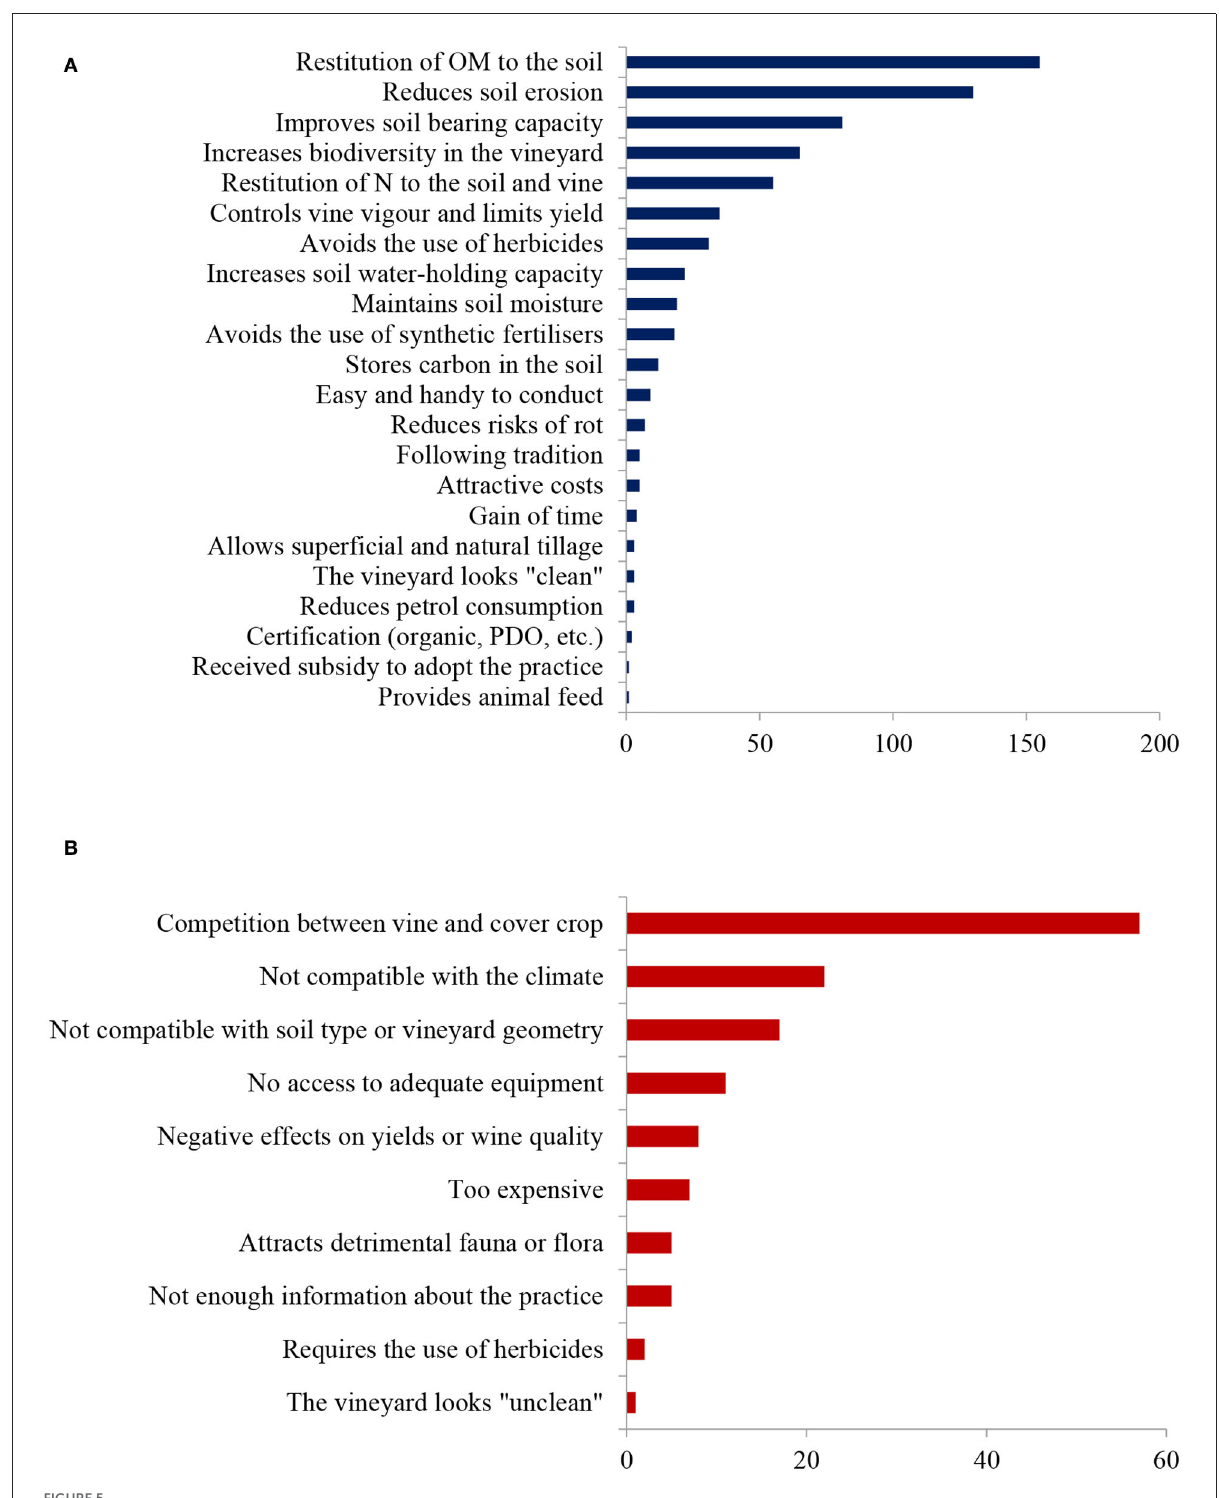
FIGURE5 Motives (A) and barriers (B) to the adoption of cover cropping in viticulture in France ( n = 341 and 108, respectively). Several responses were possible for each respondent. OM, organic matter; N, nitrogen; PDO, protected designation of origin.